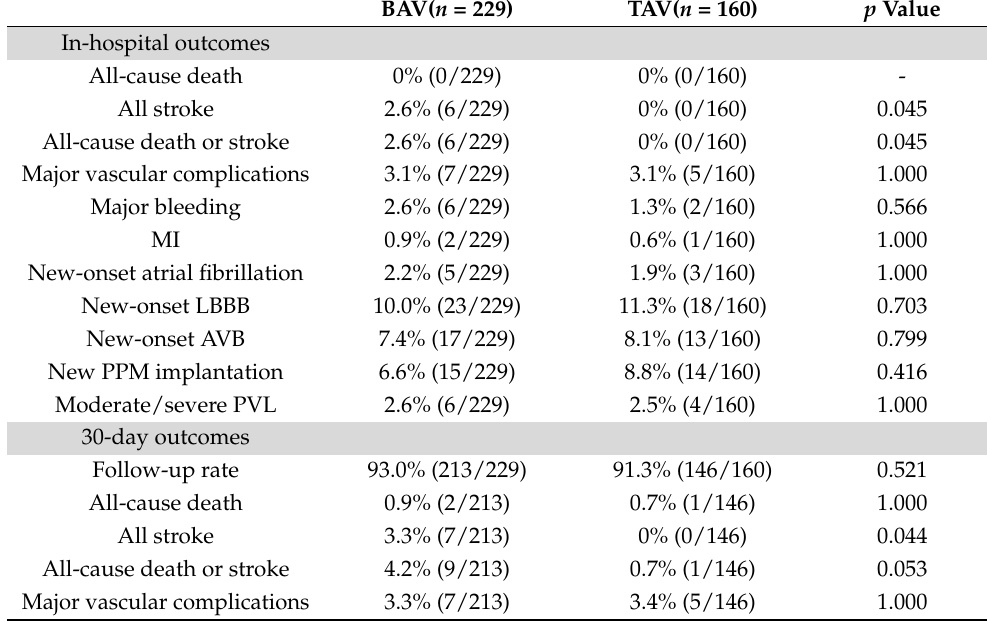
Table 3. Clinical Outcomes in the Low-Risk